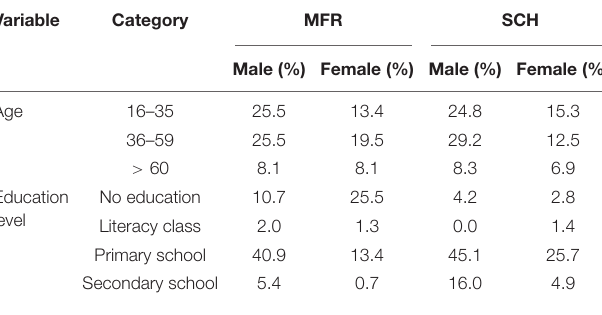
TABLE 3 | Summary of respondents’ demographic profile in study areas MFR and